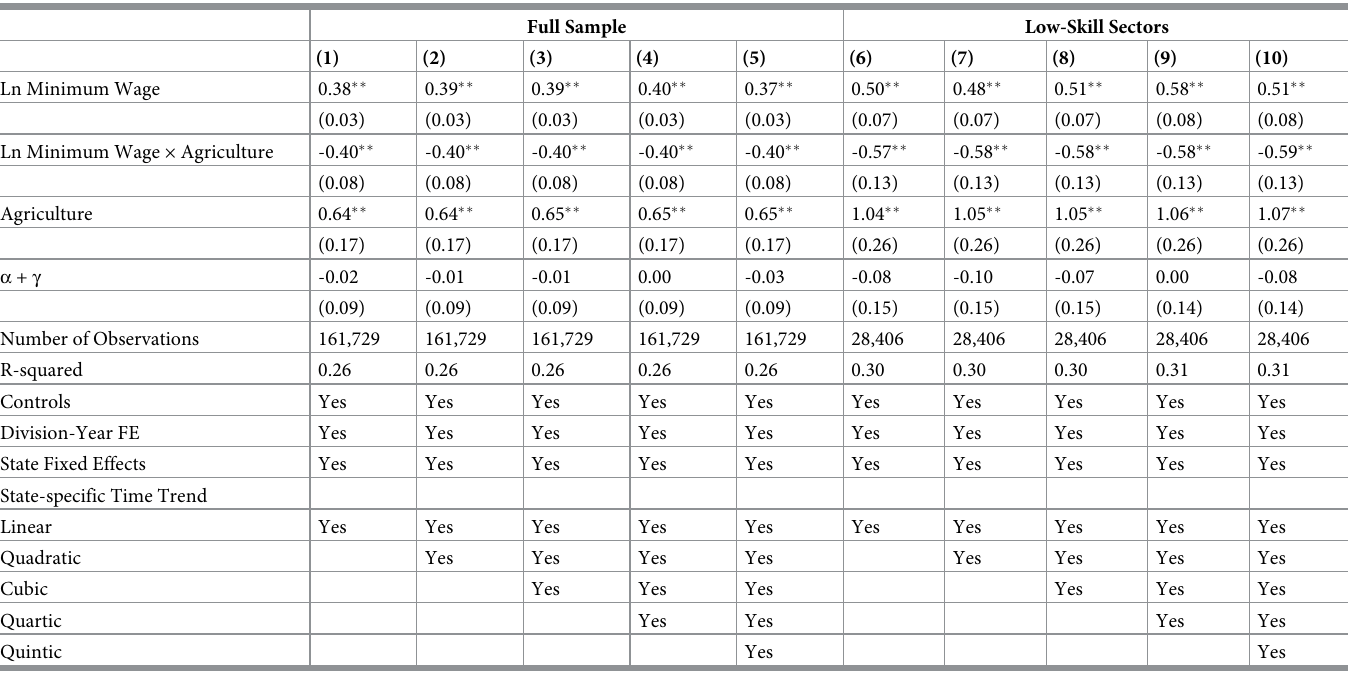
Table 2. Minimum wage law and hourly